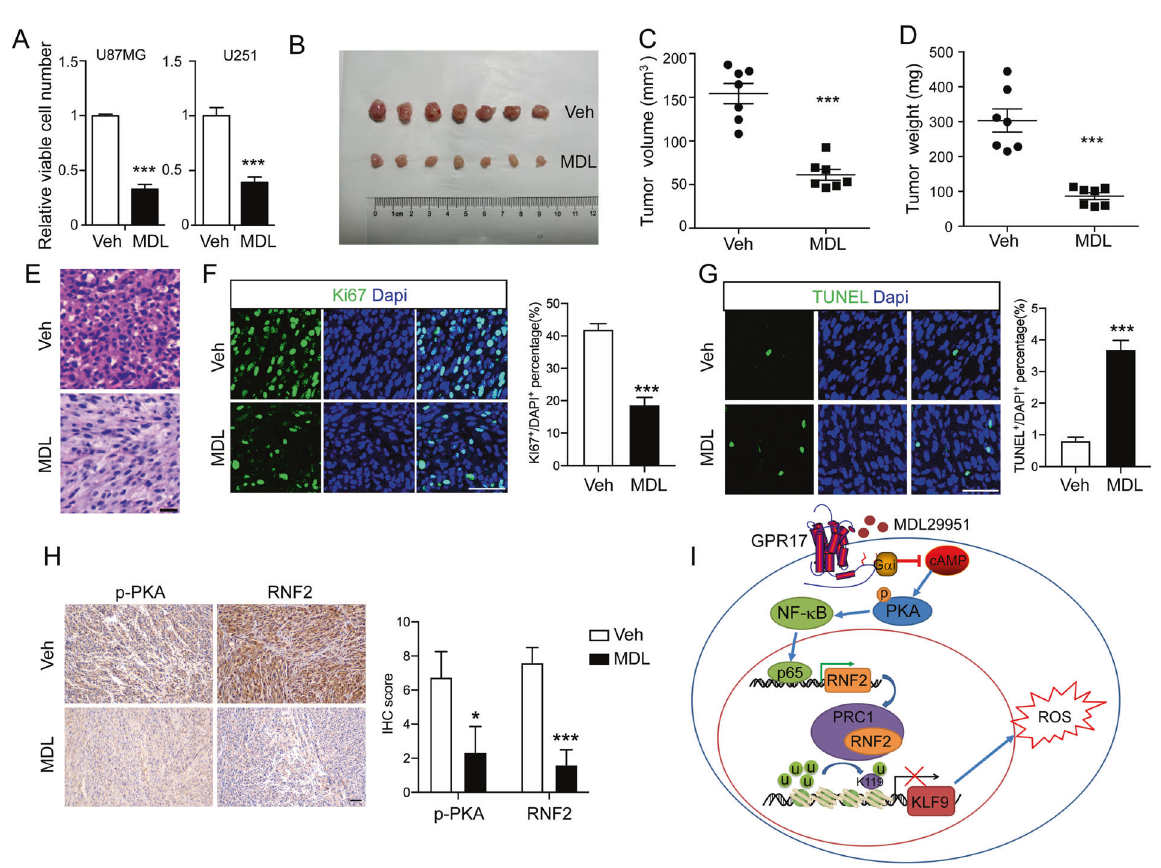
Fig. 7 Activation of GPR17 inhibited glioma formation. A U87MG and U251 cells treated with vehicle or MDL29951 (300 μ M) for 48 h, and CCK-8 assay was performed to examine viable cell numbers. Data represent the means ± SEM from three independent experiments. B – D BALB/c nude mice with subcutaneously xenotransplanted tumor were intraperitoneally injected with 10 mg/kg MDL29951 for 16 days, and then tumor samples were collected for the measurements of tumor sizes ( B ), volumes ( C ), and weights ( D ), ( n = 7). E H&E staining of sections from subcutaneously xenotransplanted tumors. Scale bar 10 μ m. F , G Immuno fl uorescent staining against Ki67 ( F ) and TUNEL ( G ) of the tumor sections, scale bar 50 μ m. H IHC staining against p-PKA or RNF2 of the subcutaneously xenotransplanted tumor. Scale bar 50 μ m. I A diagram depicting the working model of the inhibitory effect of GPR17 on glioma tumorigenesis. For all panels, * p < 0.05, *** p < 0.001, Student ’ s t-